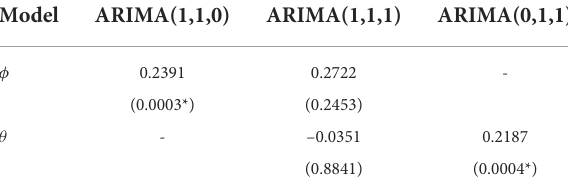
TABLE 2 Parameter estimation ARIMA( p , d , q ) model with its probability value.